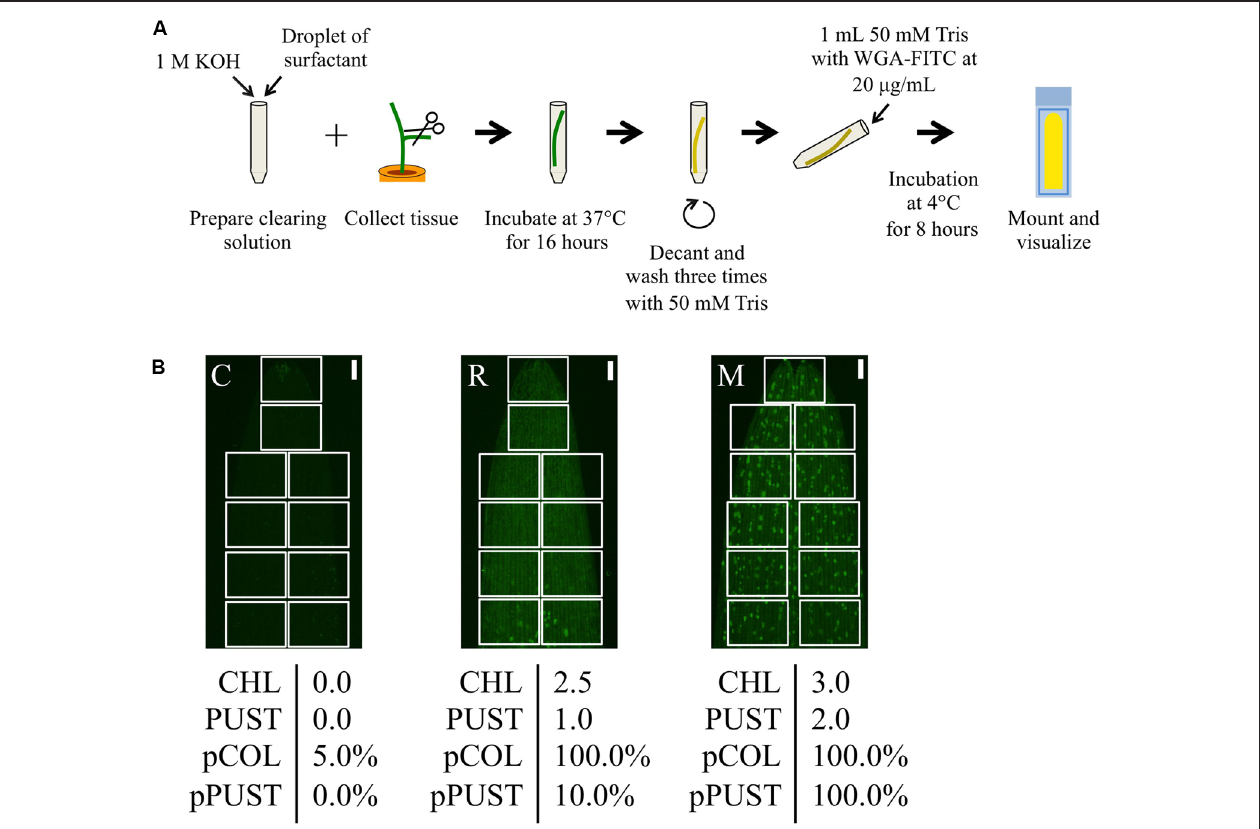
FIGURE 2 | Quantitative microscopic phenotyping of P. striiformis colonization and pustule formation using pCOL and pPUST on barley. (A) A modified WGA-FITC staining protocol based on the procedure proposed by Ayliffe et al. (2011, 2013). (B) Representative samples with macroscopic phenotypes for chlorosis (CHL) and pustule formation (PUST) were microscopically analyzed using pCOL and pPUST based on stereo micrographs of the first leaf. The microscopic assays were developed for quick evaluation through evaluating disjoint fields of view (FOV; white boxes) covering the surface area of the leaf by scanning a mounted leaf segment along either side of the longitudinal axis for barley or centered on the longitudinal axis for B. distachyon . For pCOL, an estimate is generated within each FOV based on a convex hull defined by P . striiformis hyphal growth to be less than 15%, between 15 and 50%, or greater than 50% of the FOV area and given scores of 0, 0.5, or 1, respectively. A convex hull is defined as the minimal area that contains the full extent of colonization of P . striiformis within a FOV. Disjoint convex hulls may occur within the same FOV and are used to collectively estimate the percent colonization in each FOV. Each score was recorded, with the final score determined by averaging these scores based on the total number of FOVs evaluated and ranged from 0 to 100%. pPUST was evaluated in a similar manner, although convex hulls were defined by the clustering pattern of P . striiformis pustules. From left to right, accessions CIho 4196 (C), Russell (R), and Manchuria (M). The scale bar is 1